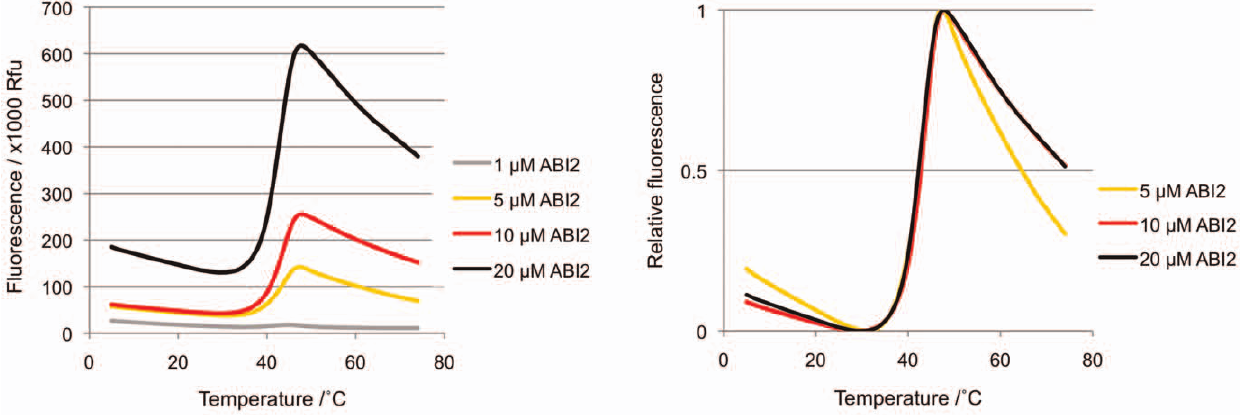
Figure 6. ABI2 melt curves at different ABI2 concentrations. The normalized melt curves are superimposed on each other in the right panel. Note that fluorescence increases with protein concentration, while the Tm is independent of ABI2 concentration.